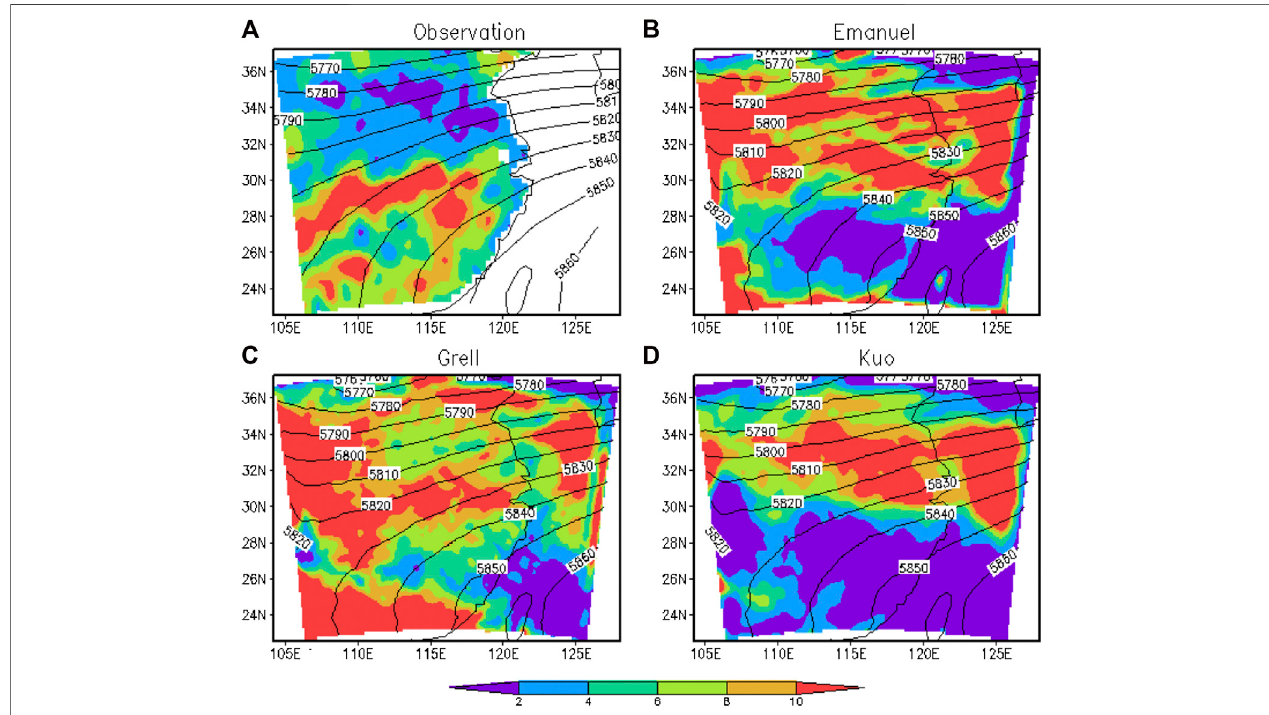
FIGURE 7 | Spatial distributions of precipitation (unit: mm/day) and 500-hPa geopotential height (unit: gpm) during the Meiyu season of 1964 from observations and simulations by the Emanuel, Grell, and Kuo schemes.